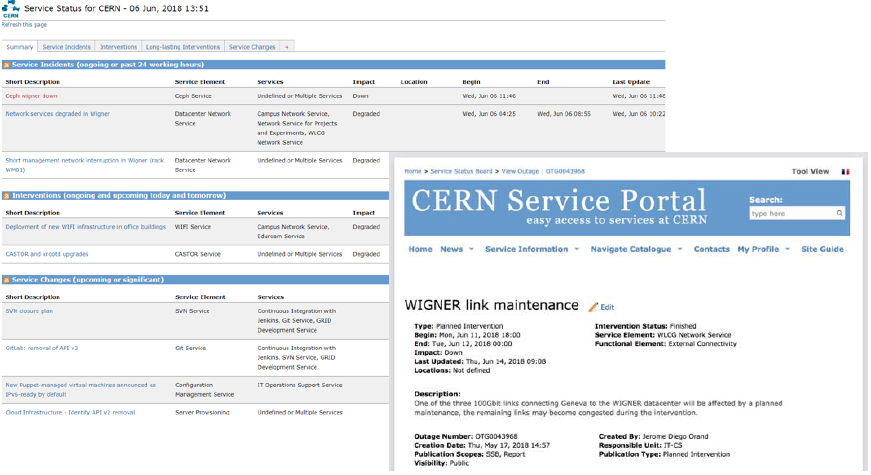
Fig. 1. The CERN Status Board homepage and an SSB Item in detail